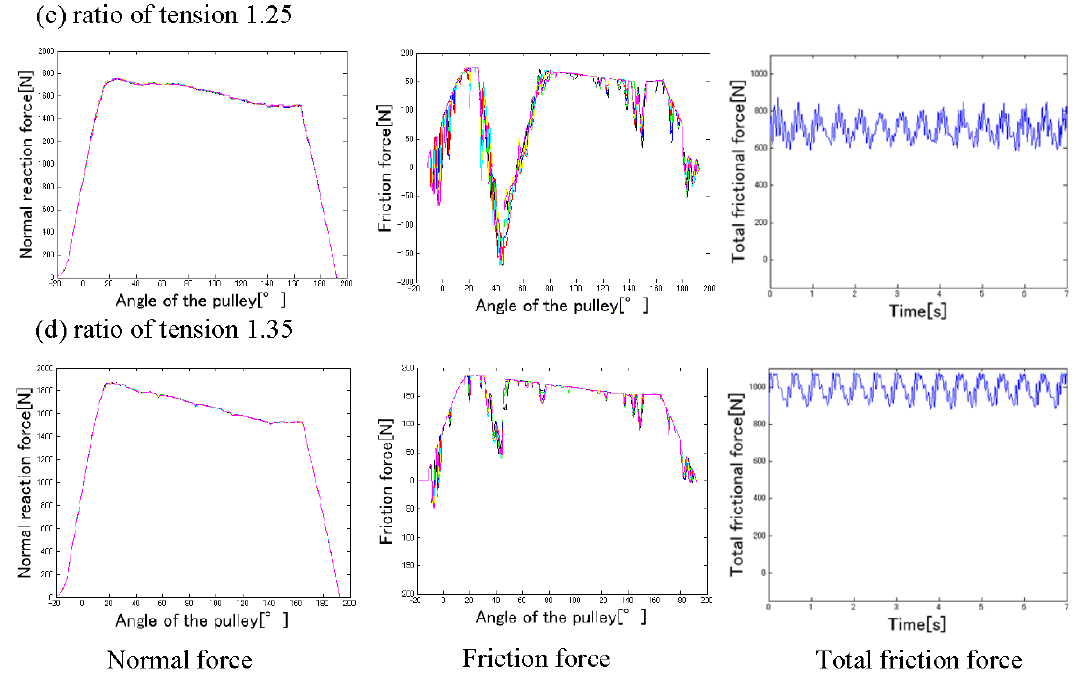
Figure 10. Time history of each force for ratios of tension between 1.00 and 1.35.